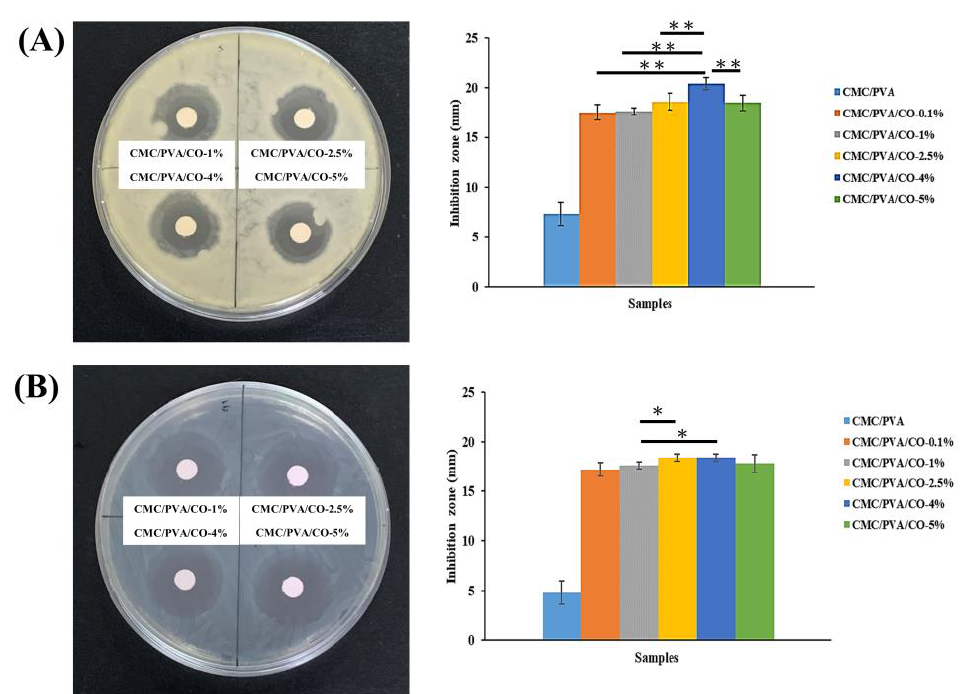
Figure 7. Inhibitory effects of CMC/PVA/CO composite films with different concentrations of CO (0.0%, 0.1%, 1%, 2.5%, 4%, and 5%) on the growth of ( A ) Gram-positive bacteria (Staphylococcus aureus) and ( B ) Gram-negative bacteria (Escherichia coli). Results are expressed as mean ± standard deviation and statistical significance is represented as (*) p < 0.05 or (**) p < 0.01.